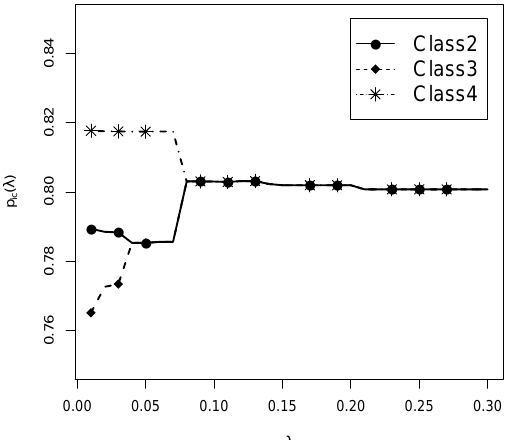
Figure 3. Data illustration dichotomous data: Regularization path for estimated item response probabilities for Item 1 for Classes 2, 3, 4 for the four-class